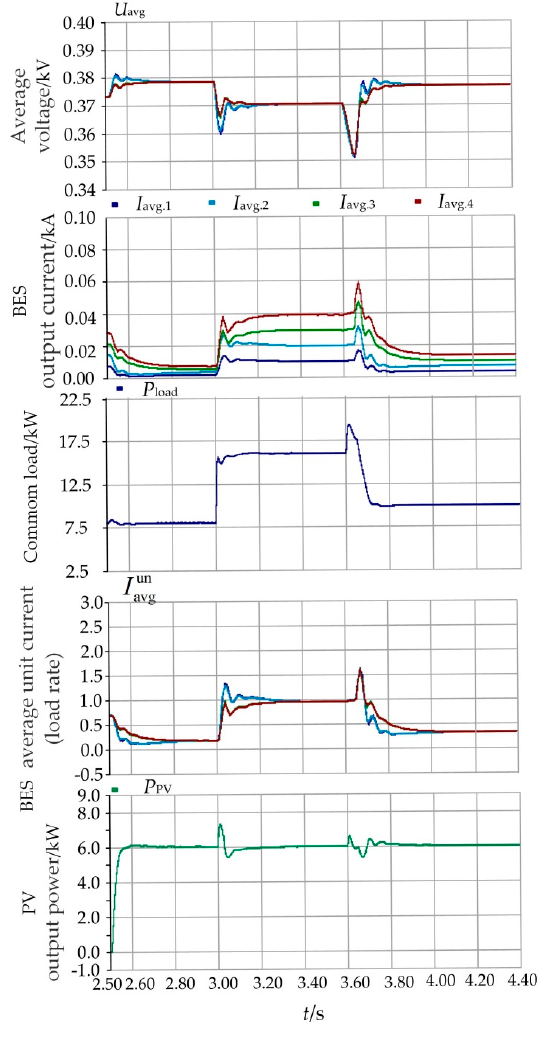
Figure 14. Simulation waveform of Situation 2.